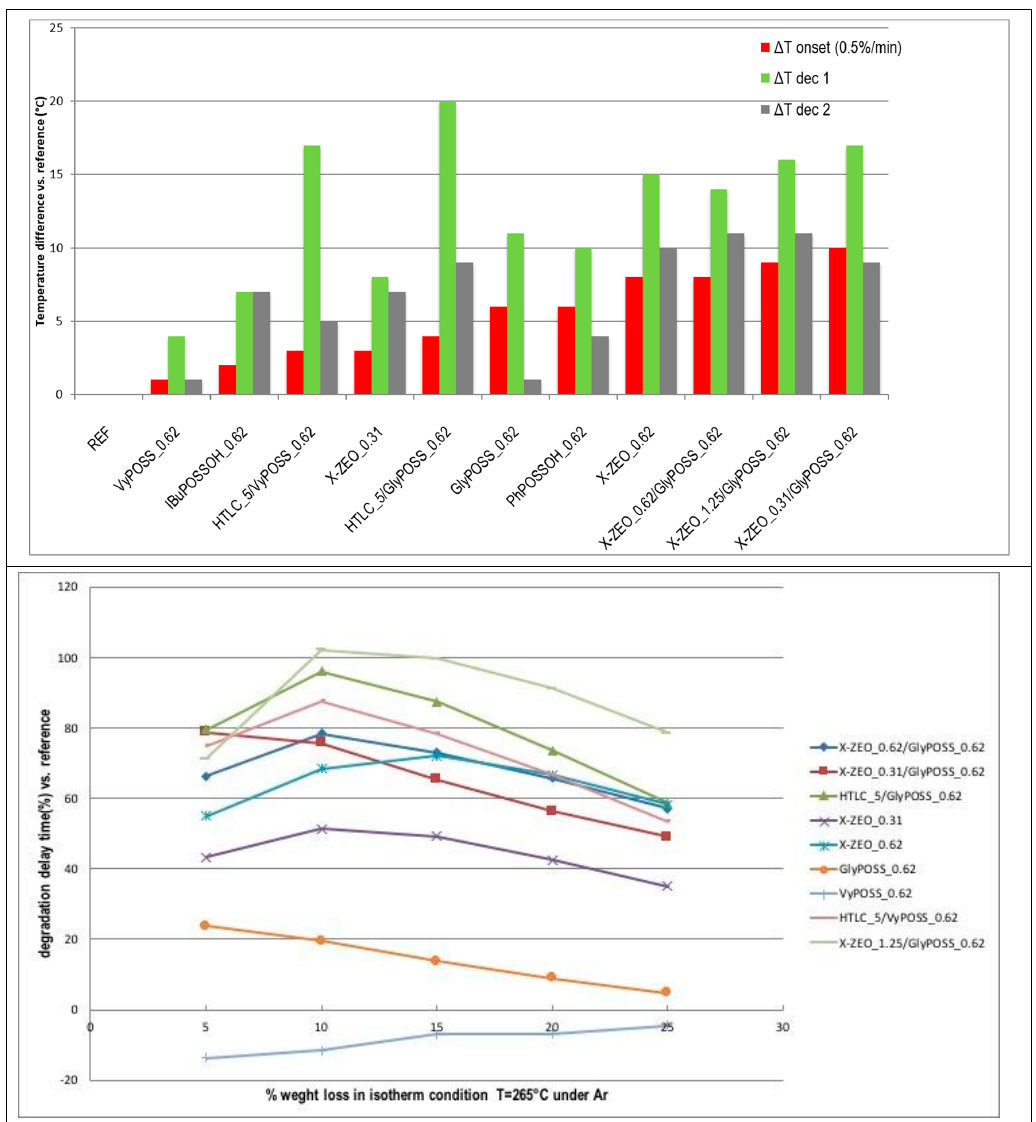
Figure 5. Graphical representation of temperature shifts (°C) of the degradation onset, the first and second decomposition process derived from ramp TGA (top) and degradation time shift derived from isothermal TGA (bottom) for nanocomposite P-PVC formulations vs. REF.